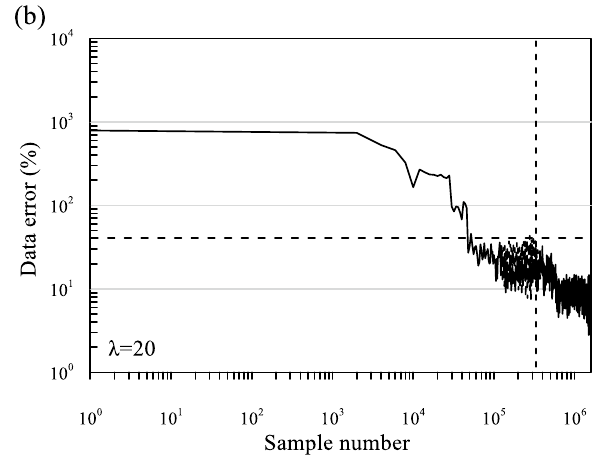
old of the end burn-in period. The total sample number is 1600000. Sampling with 𝜆 = 20 only costs > 50% sample times (~ 30,0000) of that with 𝜆 = 1 (~ 700,000) to end the burn-in period